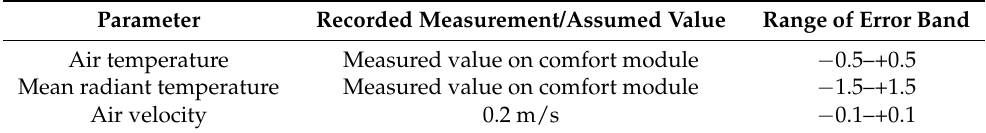
Figure 8. AC on/off probability within various IMAC comfort bands.